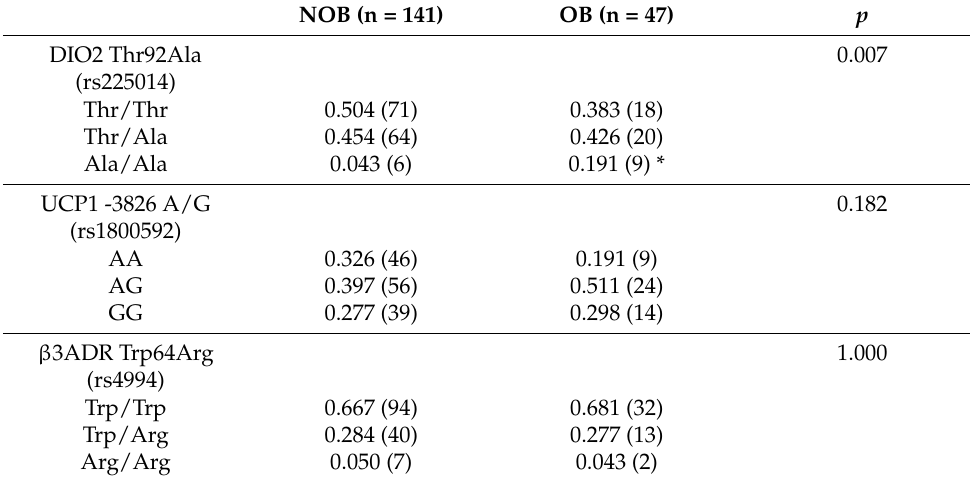
Table 7. Genotype distribution of SNPs in boys.